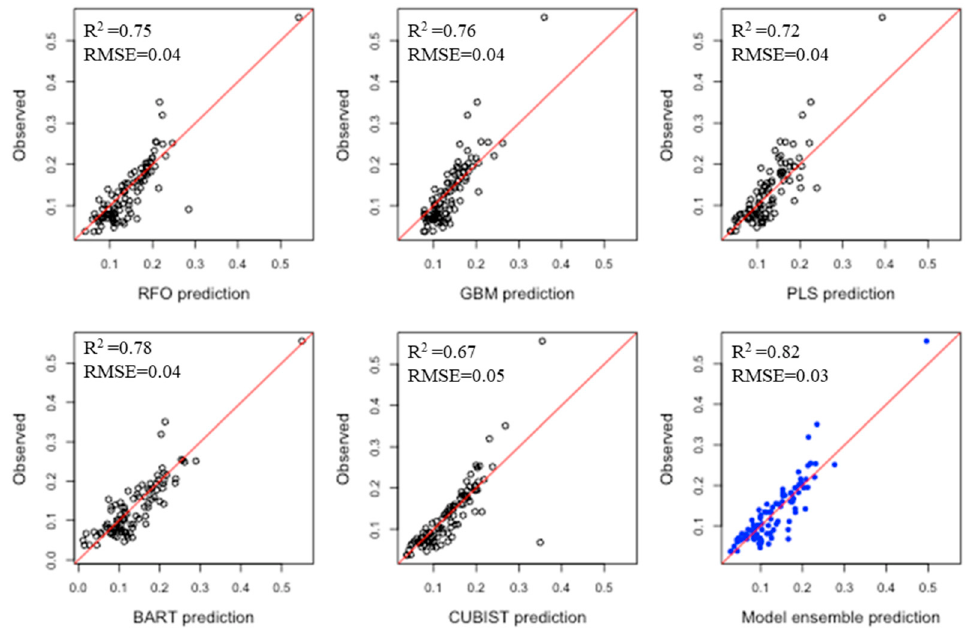
Figure 4. Scatter plot of observed and predicted total nitrogen content values using RFO, GBM, PLS, BART, CUBIST and total ensemble.